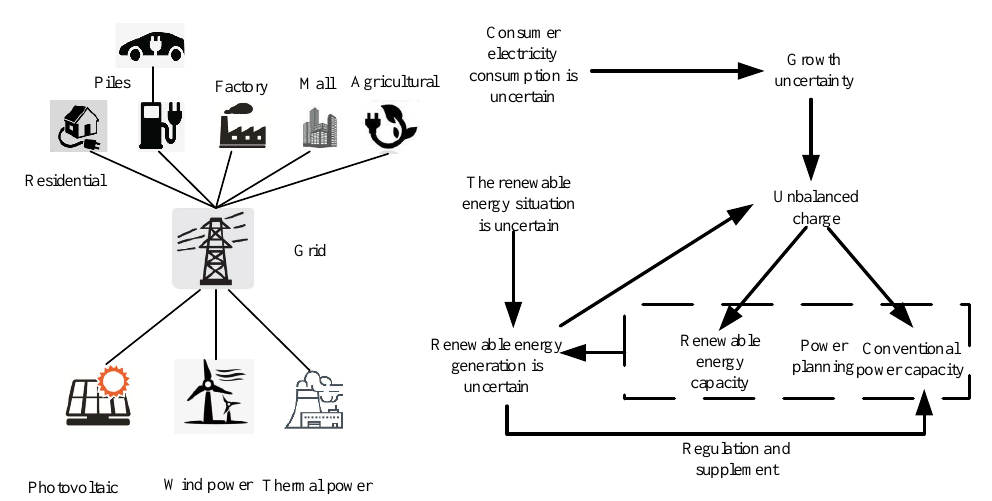
Figure 2. Generation expansion planning diagram under low carbon economy. Table 1. Evaluation index of the sustainable power structure.